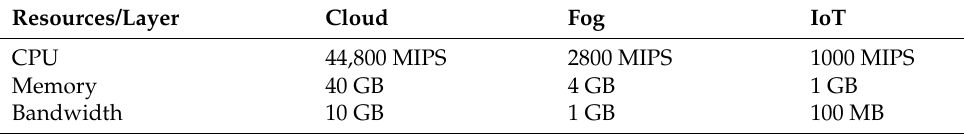
Table 5. Resources by layer (Adopted from [1]).